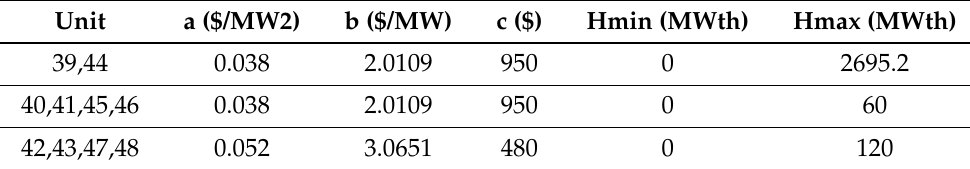
Table A15. Heat energy generator unit data for Case Study